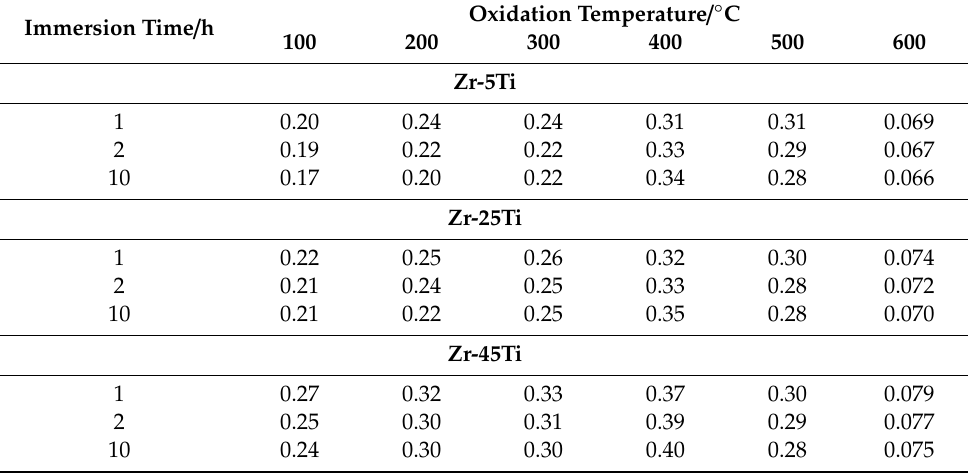
Table 2. Values of the polarization resistance (in M Ω · cm 2 ) as a function of immersion time of